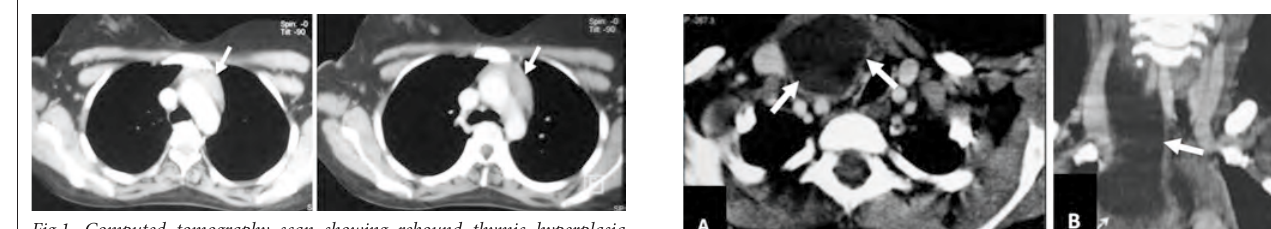
Fig.1. Computed tomography scan showing rebound thymic hyperplasia (arrows) in a 45-year-old woman post chemotherapy for cervical cancer. Fig. 2. Thymic cyst: (A) Axial contrast-enhanced CT scan shows a cystic